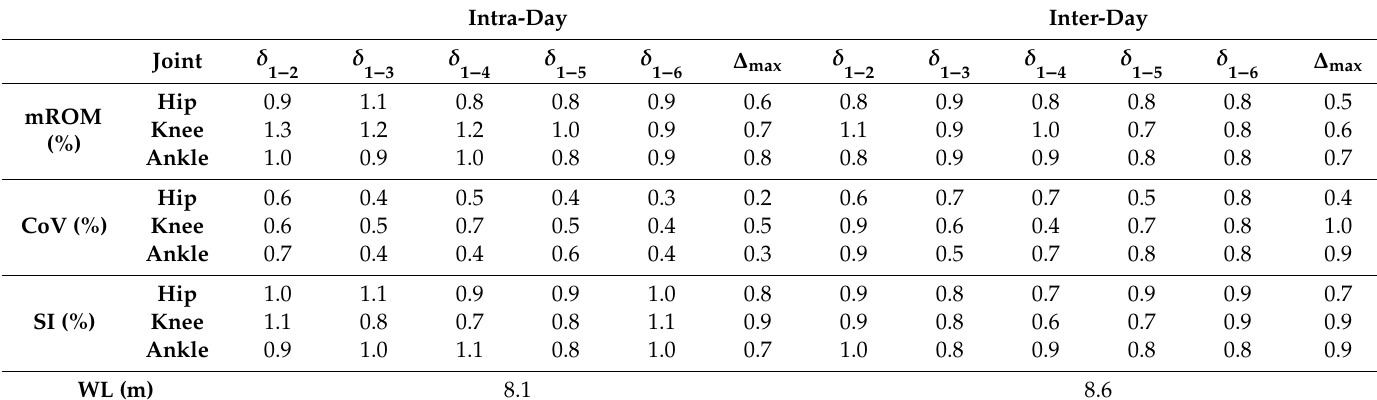
Table 4. Maximum value of SD related to the intra- and inter-day repeatability analysis for synthetic indices related to the 6MWT. We considered together the results for the left and right due to the low value of SI